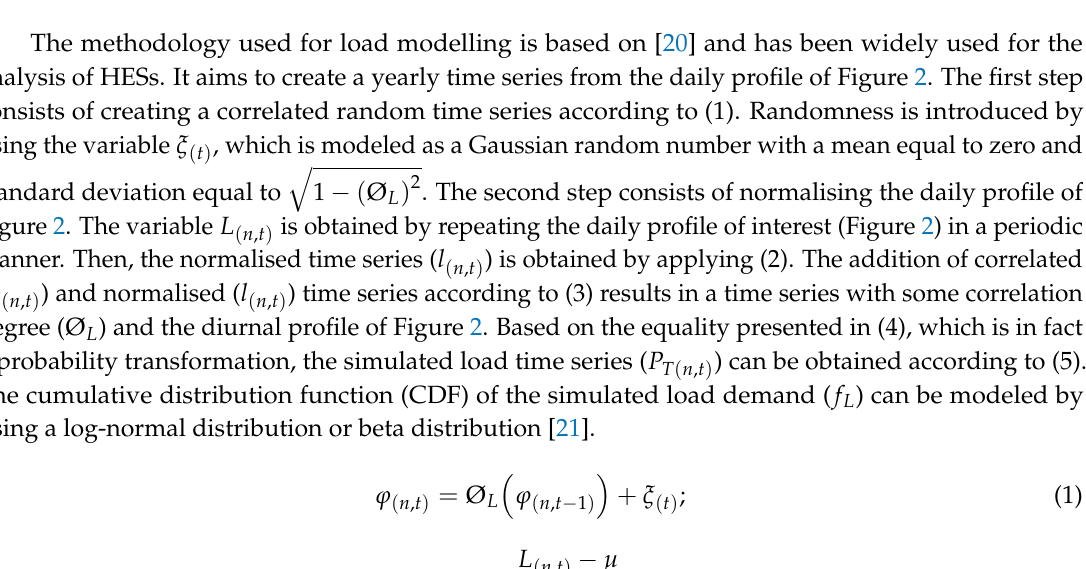
Figure 2. Load profile of small commercial loads [19].